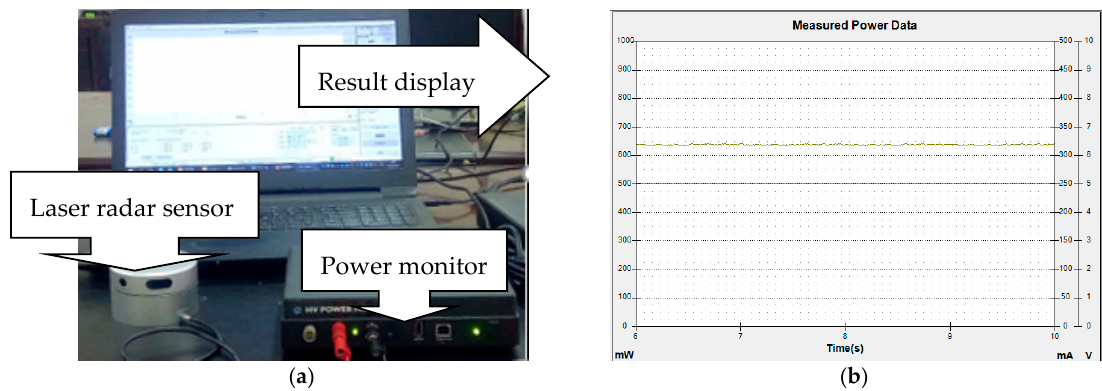
Figure 6. Power measurement of the sensor. ( a ) Sensor power measurement; ( b ) Power result display.